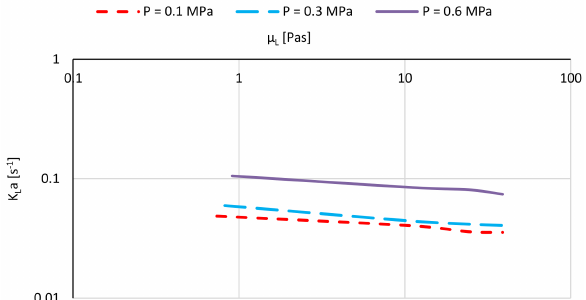
Figure 34. Influence of the operating pressure on k L a —data from Kang et al. [179]—even distribution experimental data.